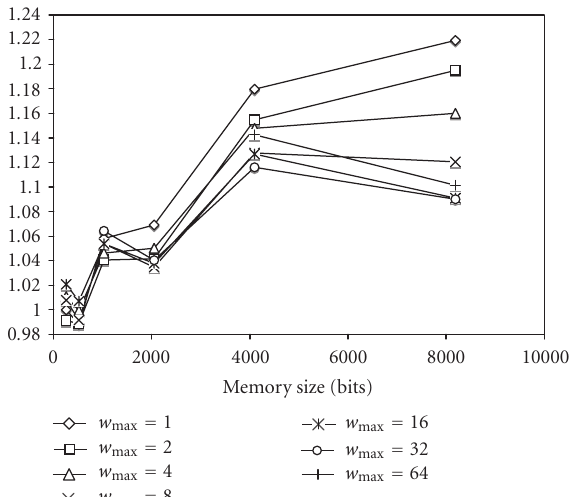
Figure 11: Impact on overall energy when increasing memory size.